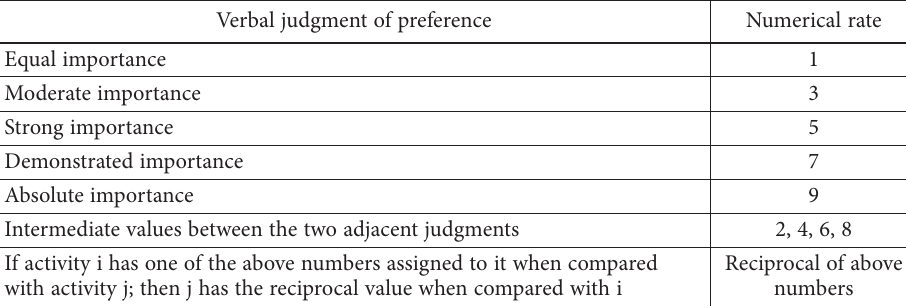
Table 3. Judgment absolute scale (source: Yurdakul & Iç, 2004) Verbal judgment of